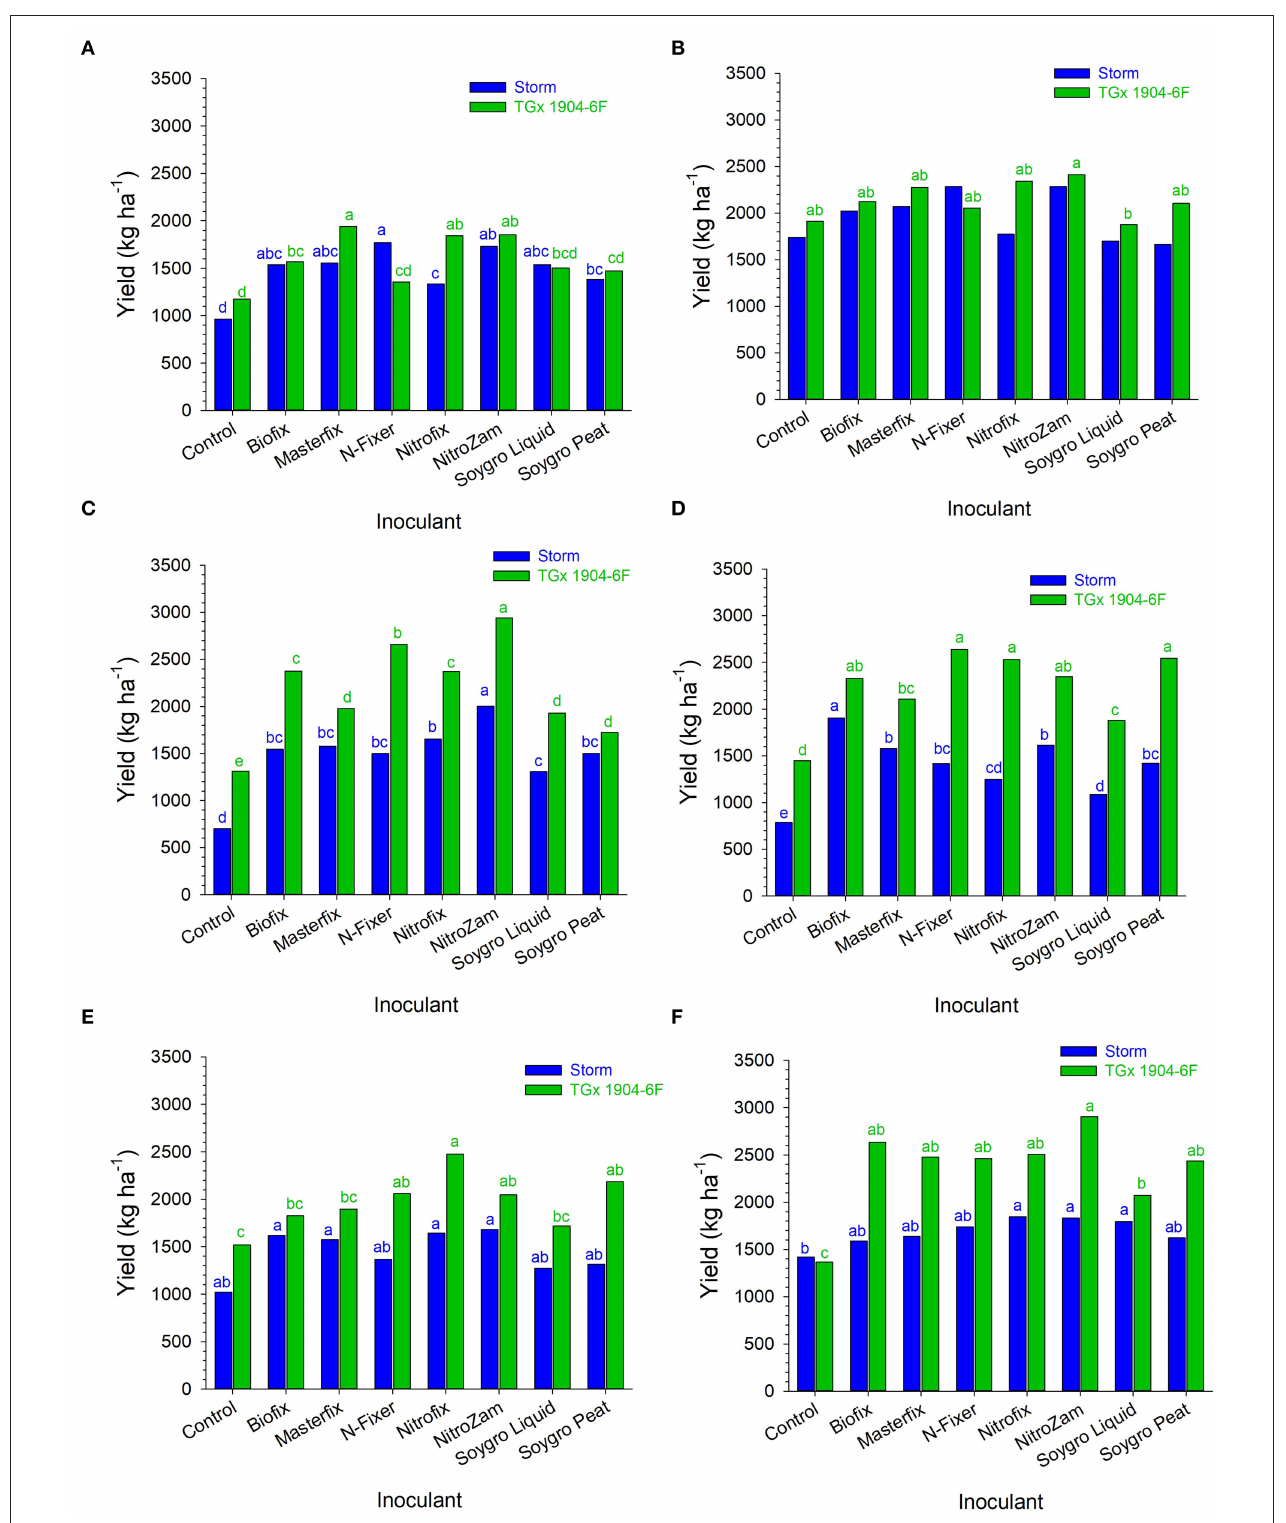
FIGURE 5 | Inoculated soybean yield in (A) Angonia 2016, (B) Angonia 2017, (C) Nampula 2016, (D) Nampula 2017, (E) Ruace 2016, and (F) Ruace 2017 growing seasons. Small letters on the bars indicate no significance while different letters show significant differences in means.